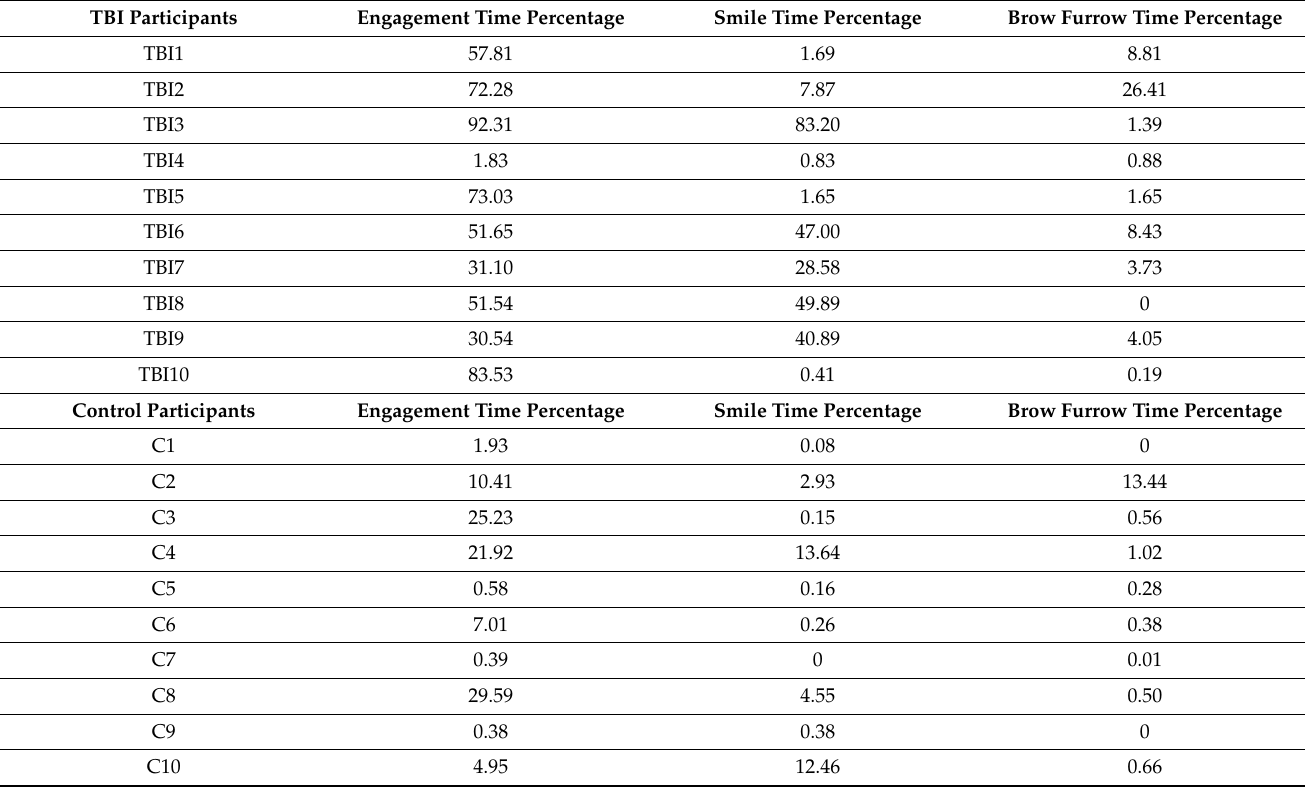
Table 5. Results generated by Affectiva of TBI participants and control participants on story narra- tive